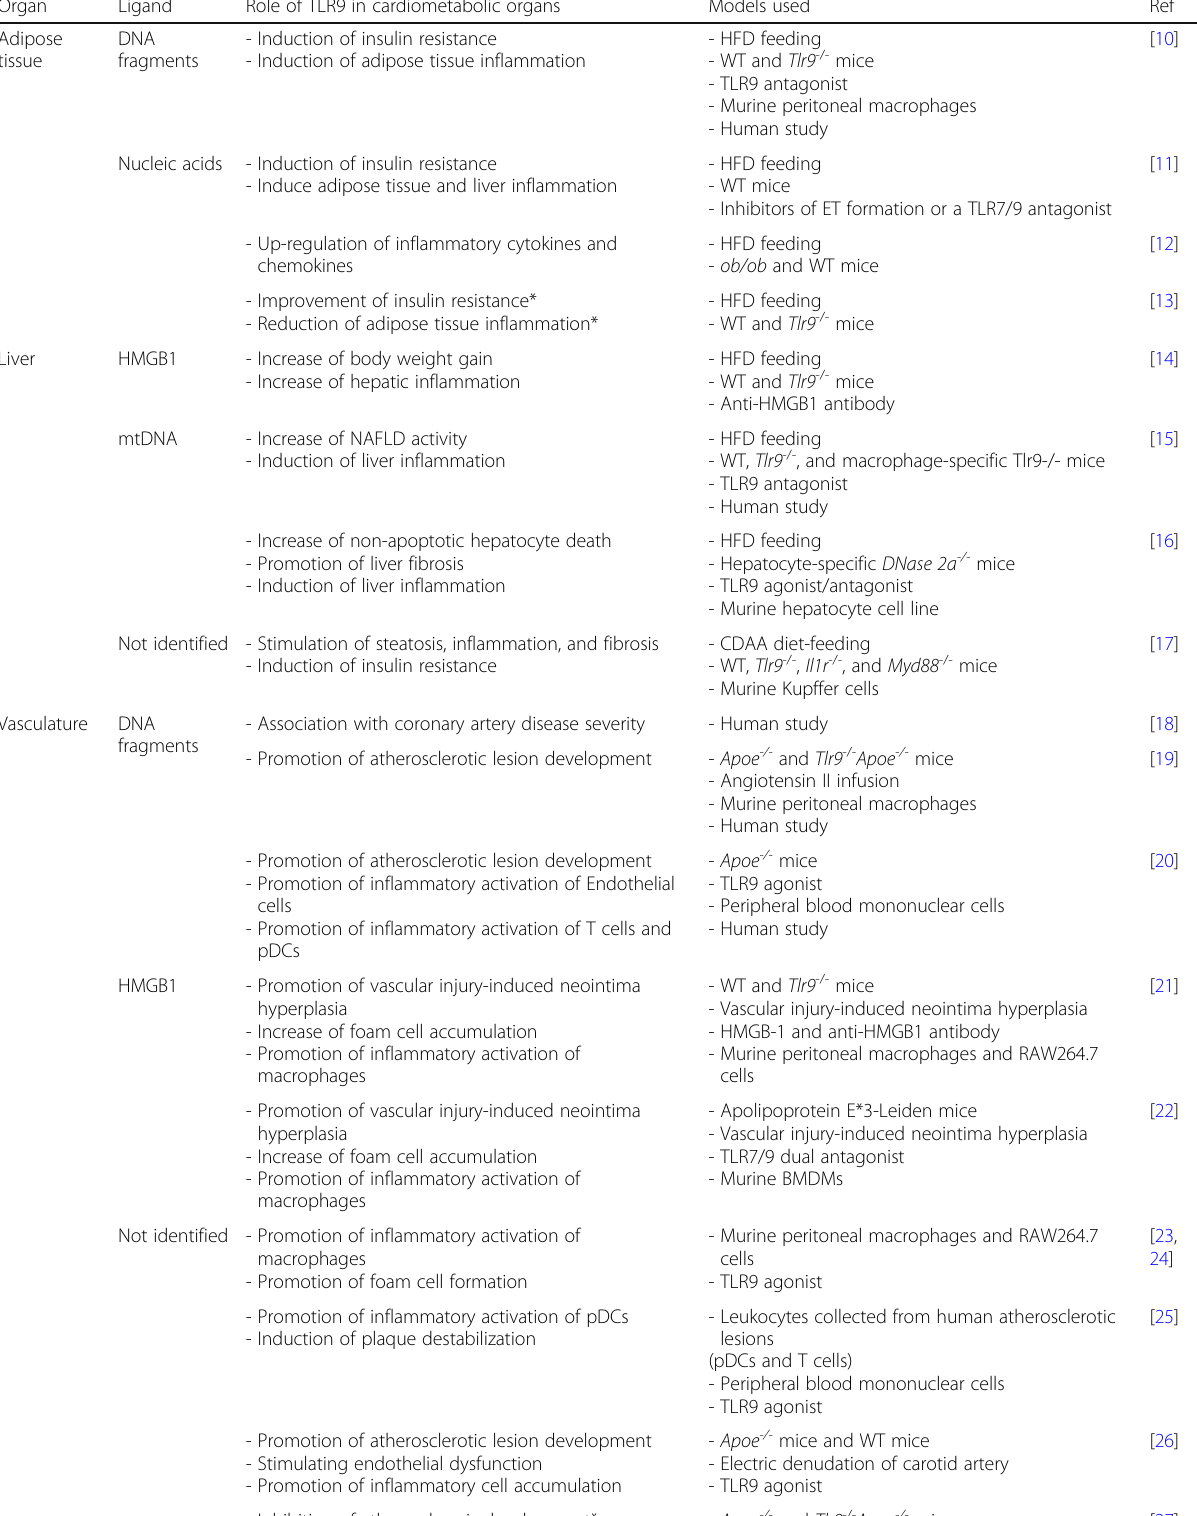
Table 1 Potential ligands and roles of TLR9 in cardiometabolic